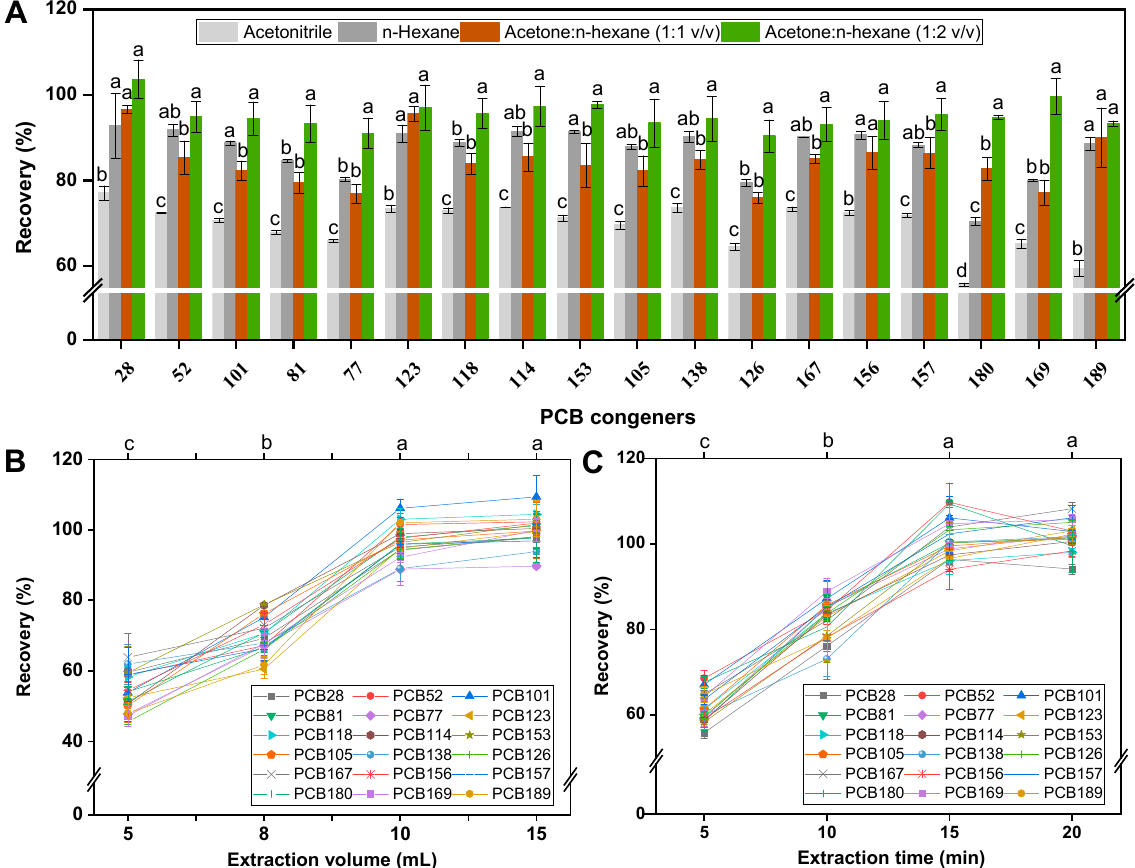
Figure 3. Effects of ( A ) type of extraction solvent, ( B ) volume of extraction solvent, and ( C ) extraction time on extraction efficiency ( n = 3). Different lowercase letters indicate significant differences at p < 0.05 under different treatments.